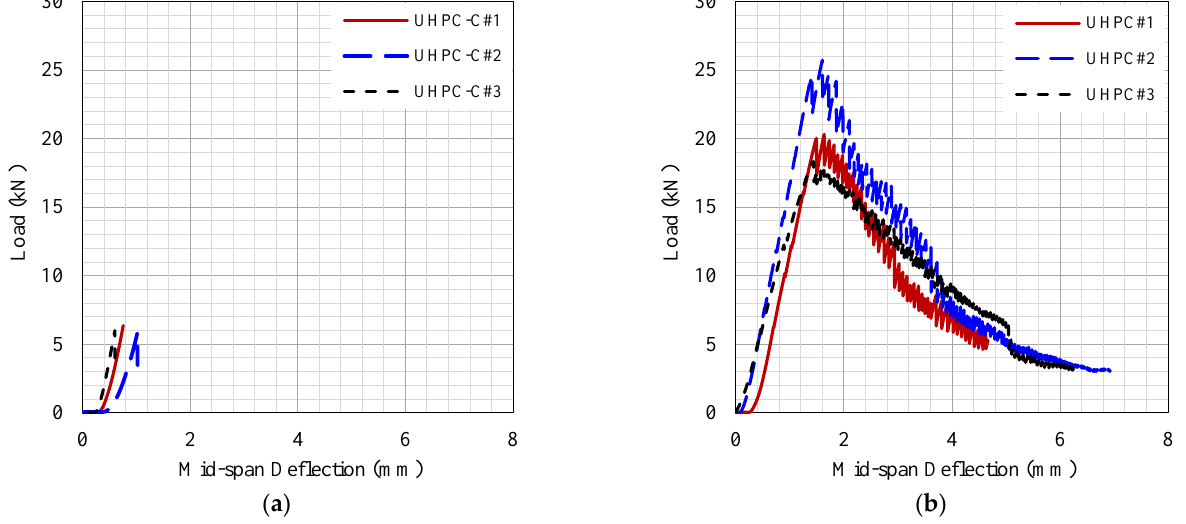
Figure 6. Flexural load displacement response: ( a ) UHPC-C, ( b ) UHPC.